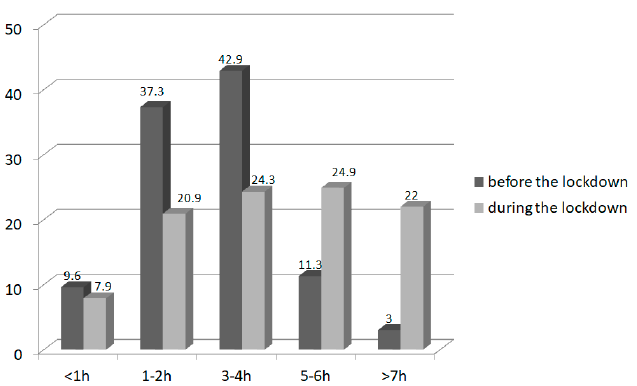
Figure 4. Screen time (in hours per day) in children (n = 177) before and during the lockdown.